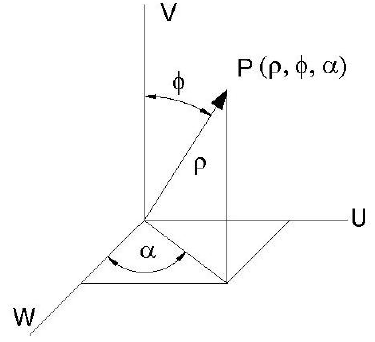
Figure 10. Polar coordinates of the velocity vector measured by the 3D sonic anemometer.